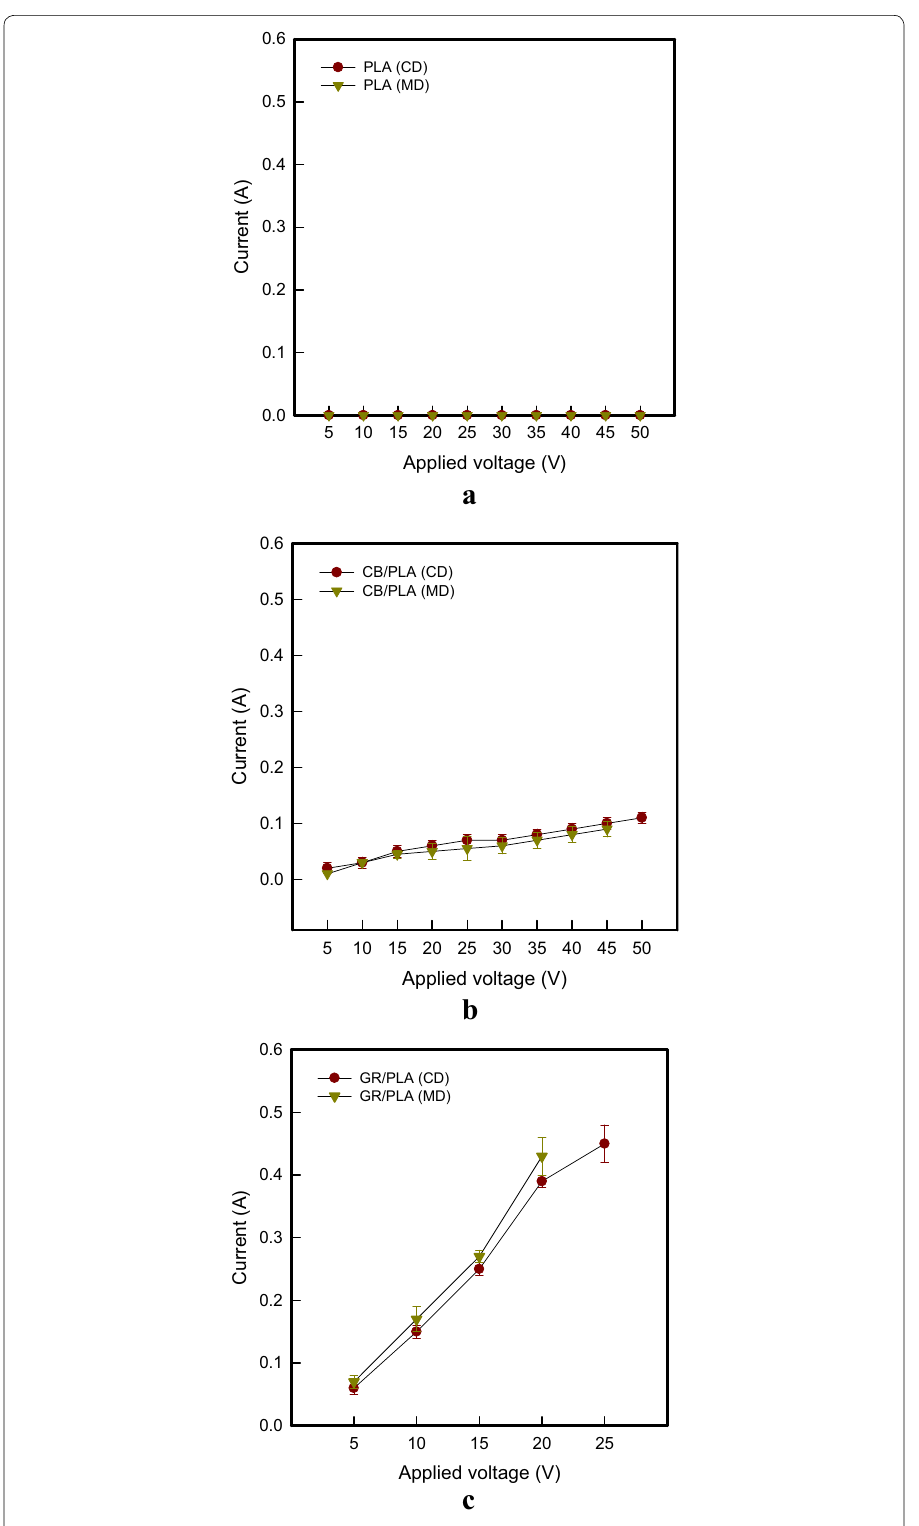
Fig. 7 Current–voltage ( I – V ) curve of 3D printed honeycomb samples a PLA, b carbon black/PLA, and c graphene/PLA with various